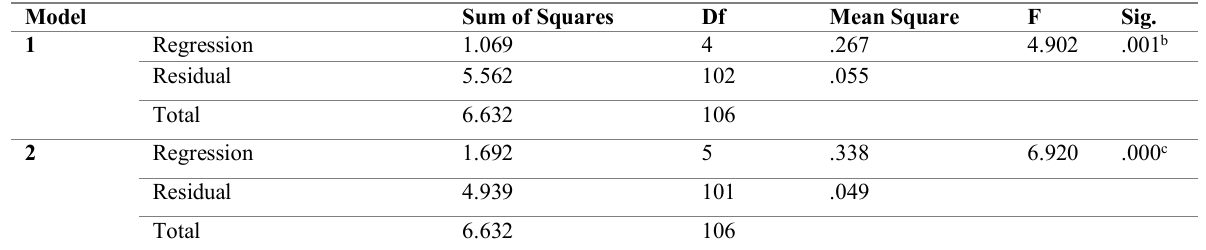
Table 14: Regression ANOVA after moderation